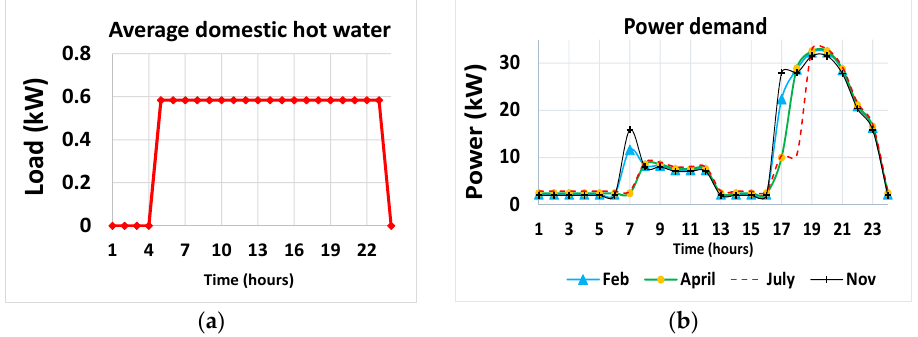
Figure 5. Average domestic hot water load demand ( a ) and electric power demand of the buildings for four months ( b ).